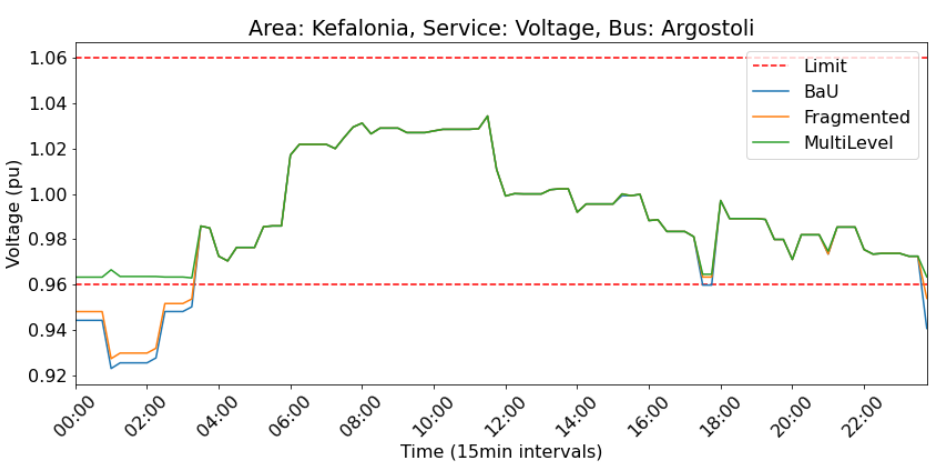
Figure 8. Example of a daily voltage variation at Argostoli substation during August when peak load